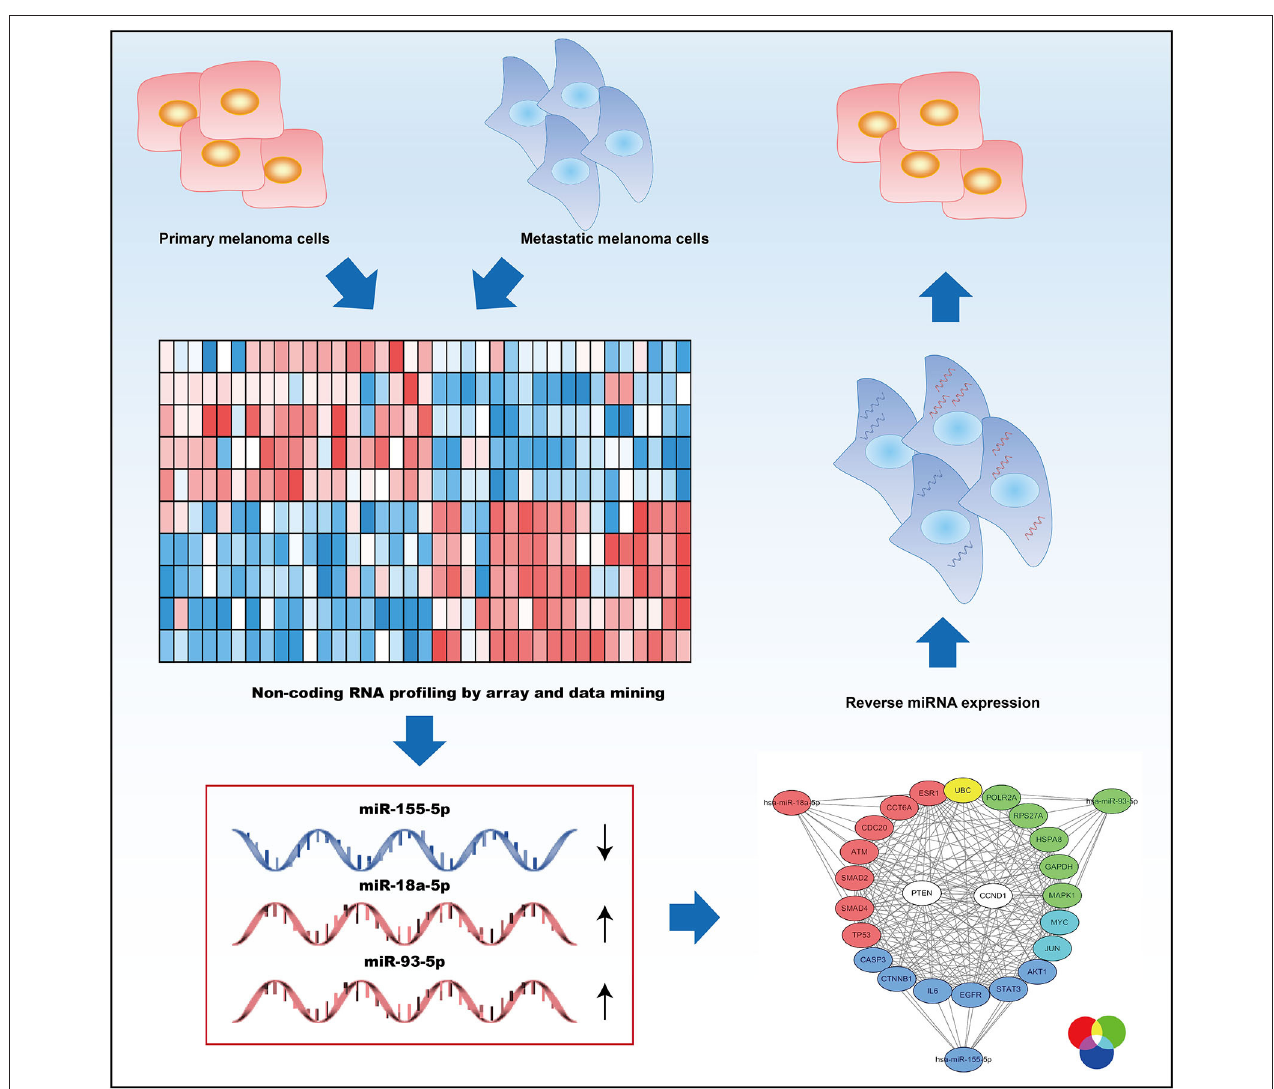
FIGURE 6 | A schematic illustration of the metastasis-associated microRNAs in